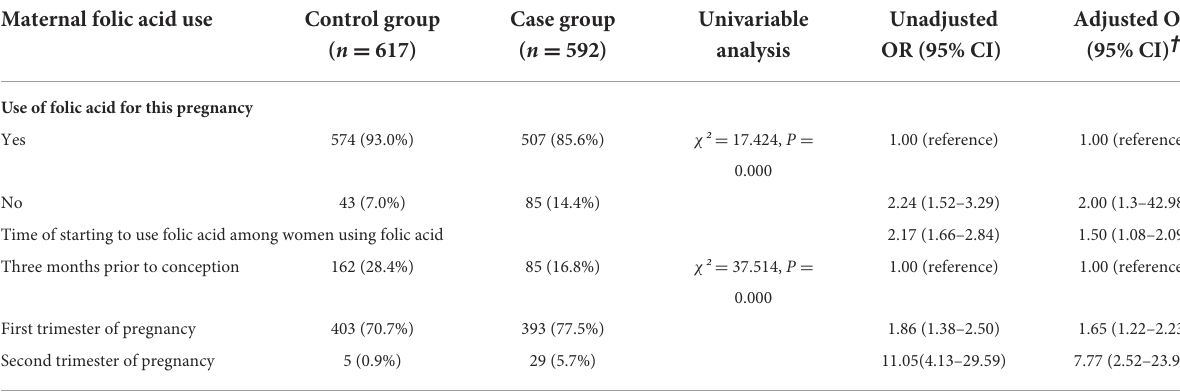
TABLE 2 Association of maternal folic acid use with the risk of CHD. Maternal folic acid use Control group